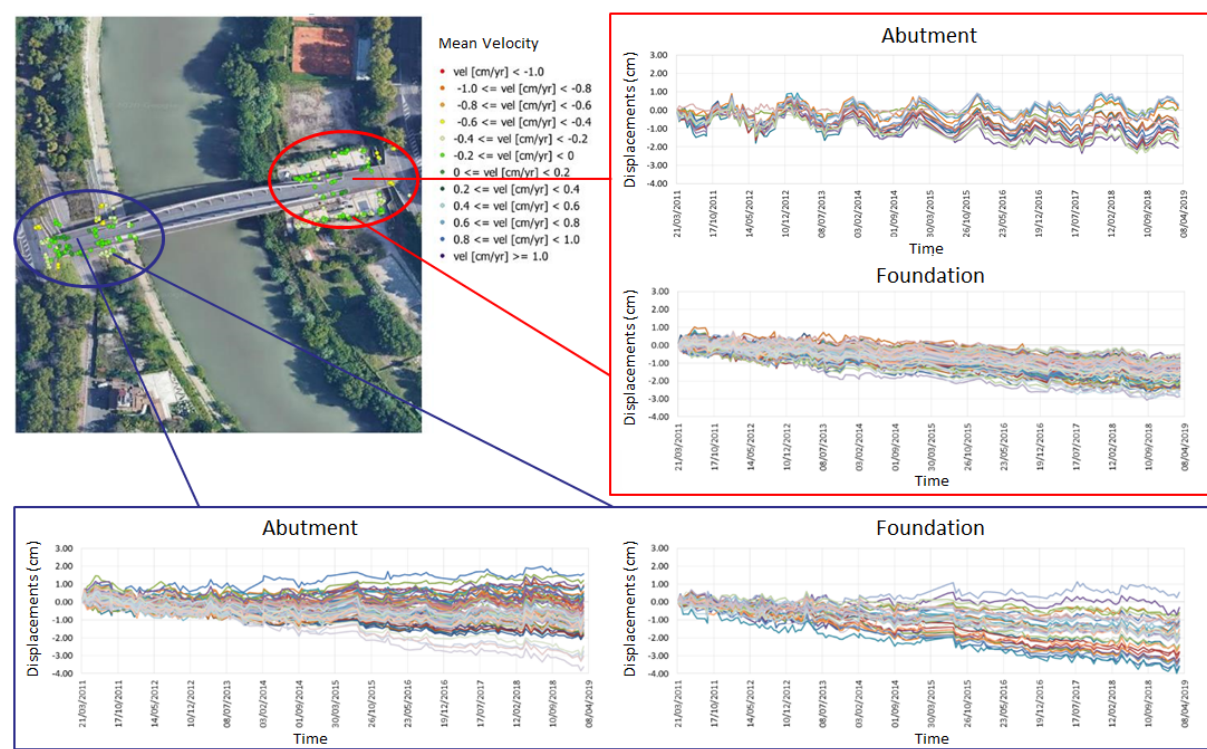
( b ) Figure 7. False colors mean deformation velocity maps of the study bridge: ( a ) ascending and ( b ) descending orbits. Figure 7 clearly shows that the points detected by the satellite are present only on the bridge abutments and foundation but not on the deck. The deformation velocity ranges